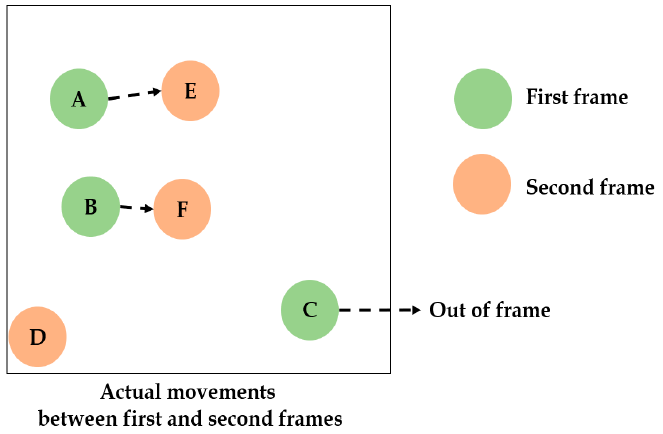
Figure 6. Example of object positions in two consecutive frames.